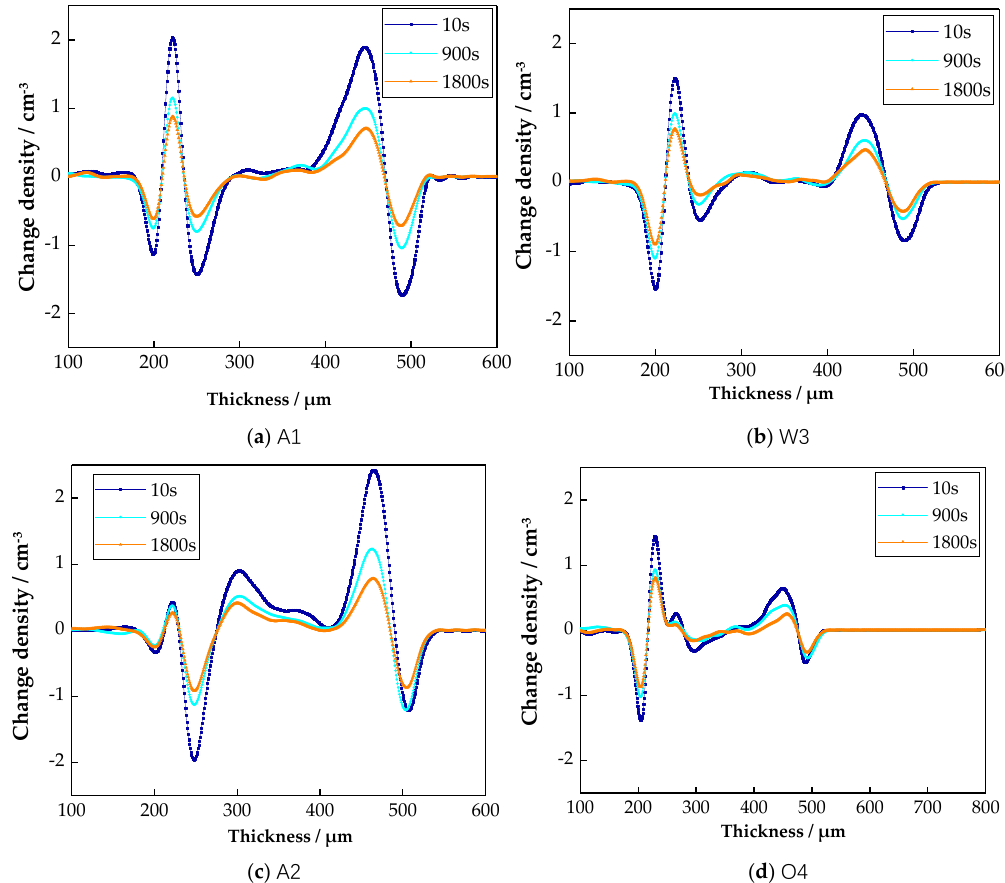
Figure 8. Space charge attenuation of LDPE under different cooling media when short-circuited.